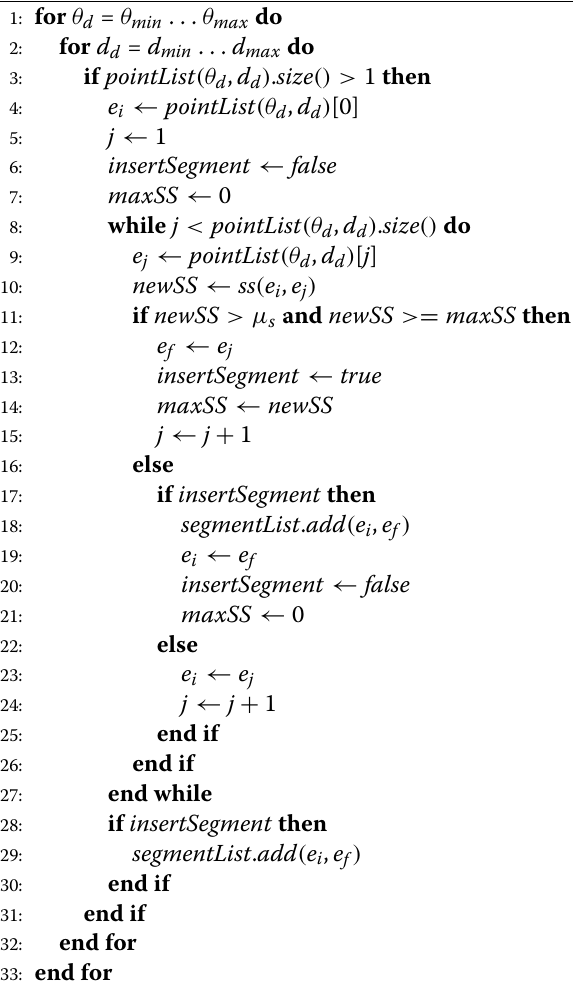
Algorithm 3 Segment